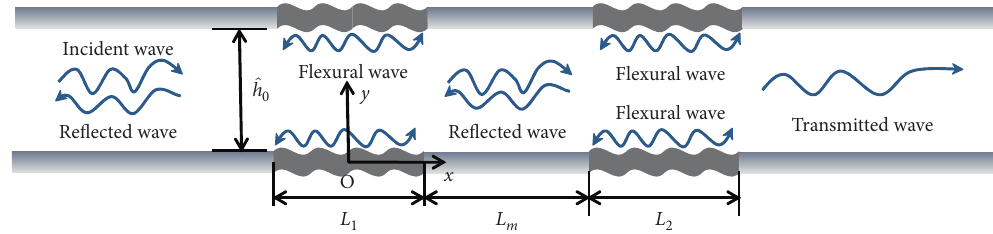
Figure 1: Illustration of duct noise control setup through the membranes in